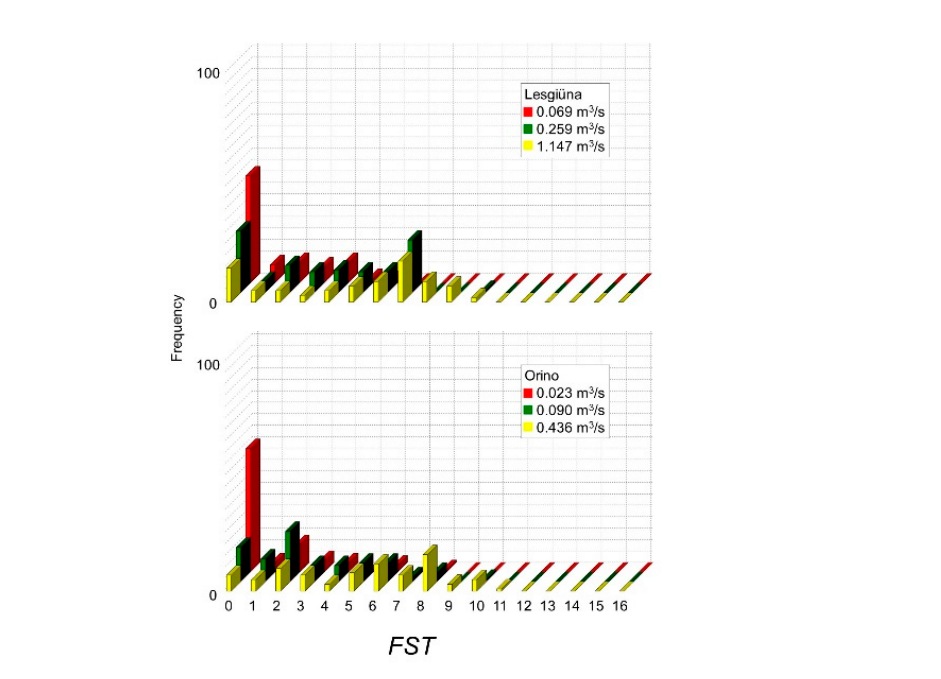
Figure A2. CASiMiR hydraulic model fit to observed values of FST numbers at the measured discharges in the Orino and the Lesgiüna.